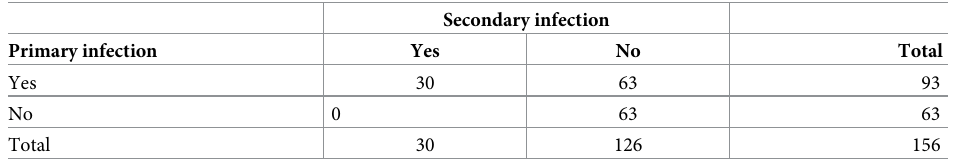
Table 5. Primary and secondary pneumonia infections of